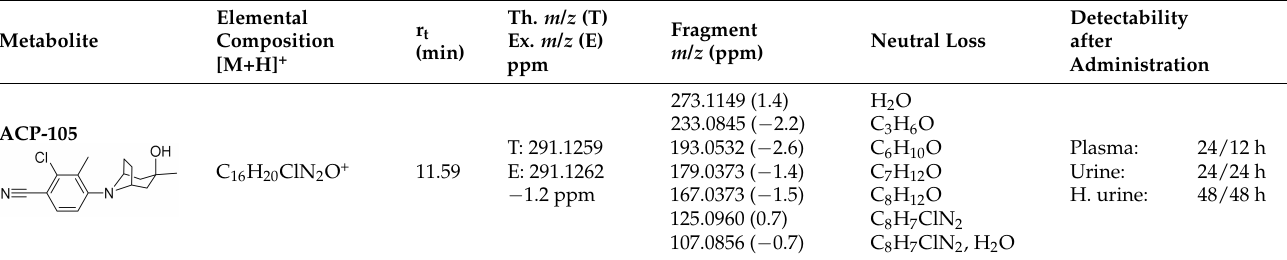
Table A1. The metabolites from ACP-105 tentatively identified in plasma, urine and hydrolyzed urine (H. urine) which represents urine treated with β -glucuronidase. The theoretical m / z (Th. m / z ) is based on the elemental composition and the experimental m / z (Ex. m / z ) is from analysis with positive electrospray ionization (ESI). The column Detectability after administration indicates for how long the analyte was detectable in the different matrices after administration and represents horse A and B in the format of A/B h. The samples were taken 0–96 h from the time of administration. A total of 21 metabolites from ACP-105 were tentatively identified, labeled M1a–M9b consisting of hydroxylations, loss of two hydrogens, glucuronidations and combinations of these metabolic